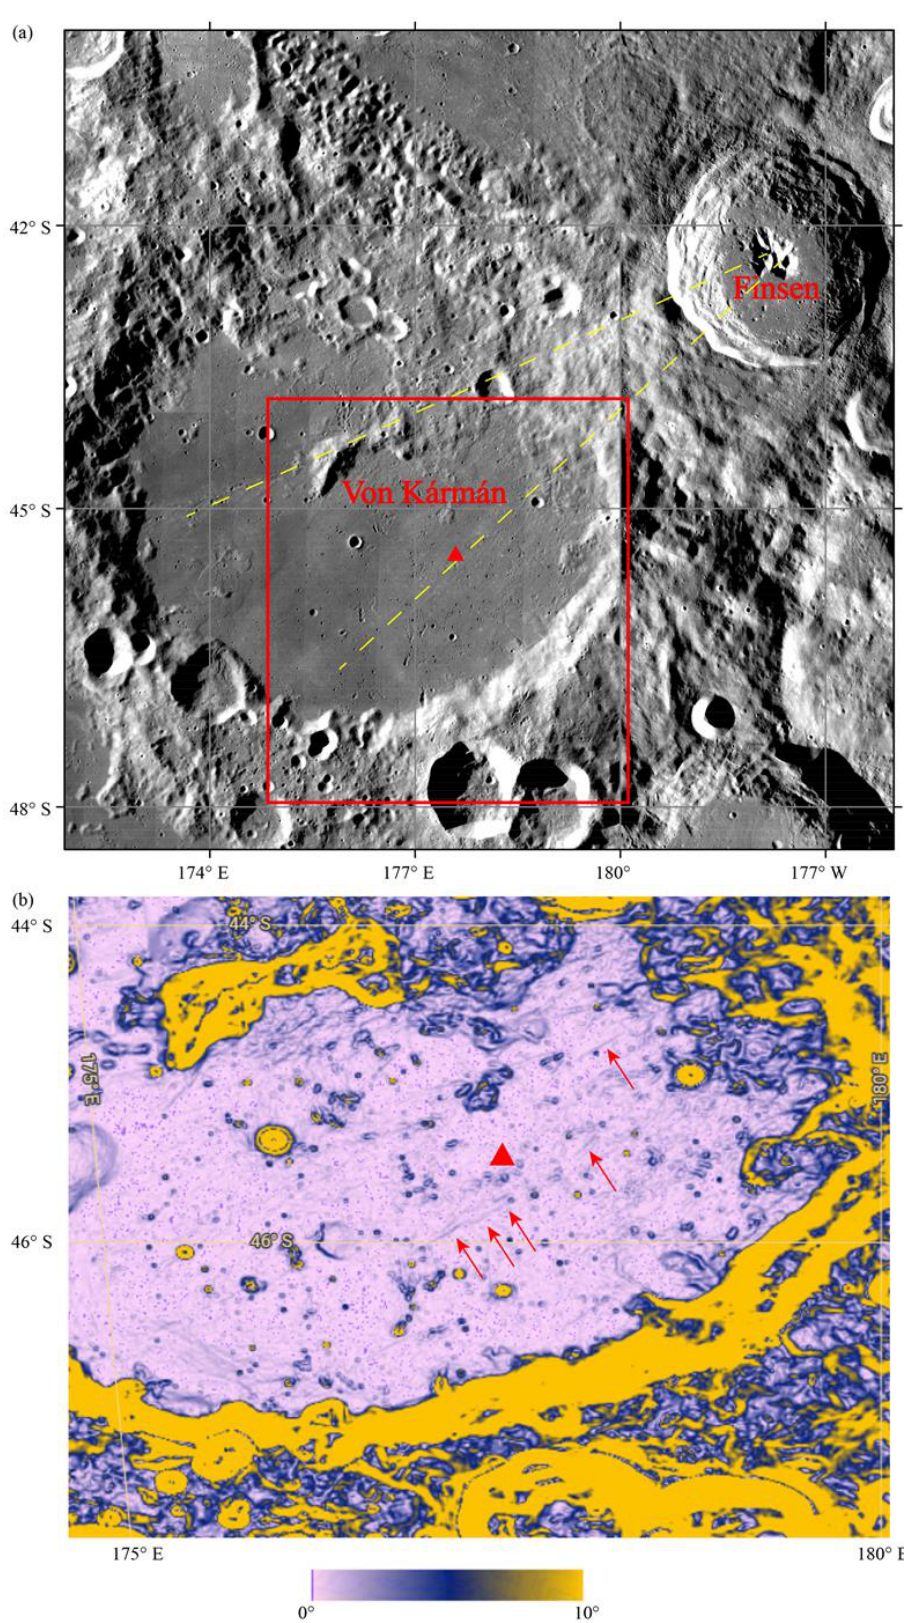
Figure 1. The landing site of Chang’e-4. ( a ) The base map obtained from Lunar Reconnaissance Orbiter Camera (LROC) Wide-Angle Camera (WAC) images [4]. The landing site of Chang’e-4